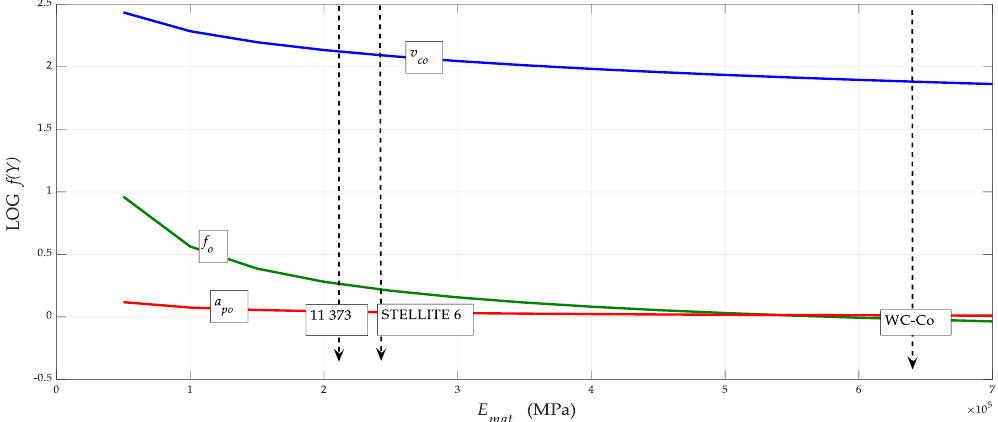
= f ( E mat ) for Stellite.